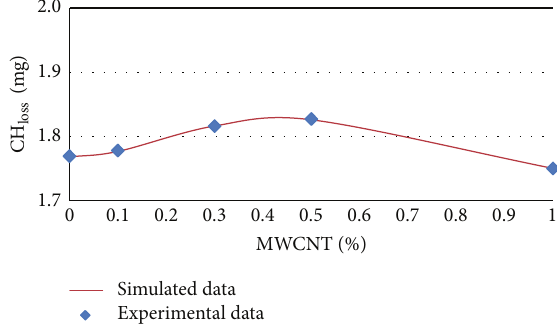
Figure 10: Experimental and simulated values of CH loss for 14 days by artificial neural